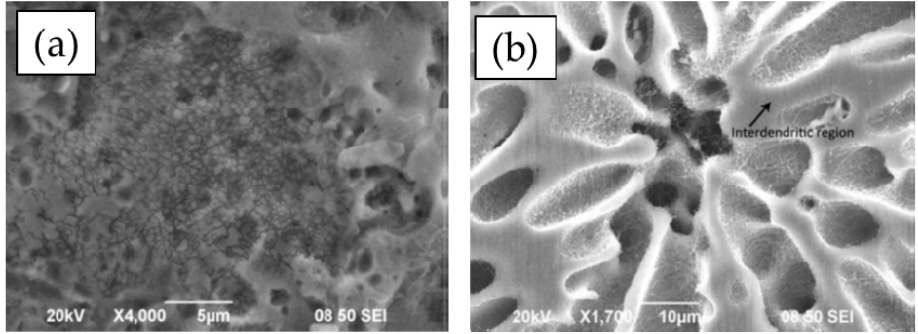
Figure 16. ( a ) Uniform corroded surface of AlCoCrFeNi CCA coating processed by electrospark after polarization test in NaCl, ( b ) Non-uniform corroded surface of a cast AlCoCrFeNi CCA in the same solution [62] (reprinted with permission from Springer).